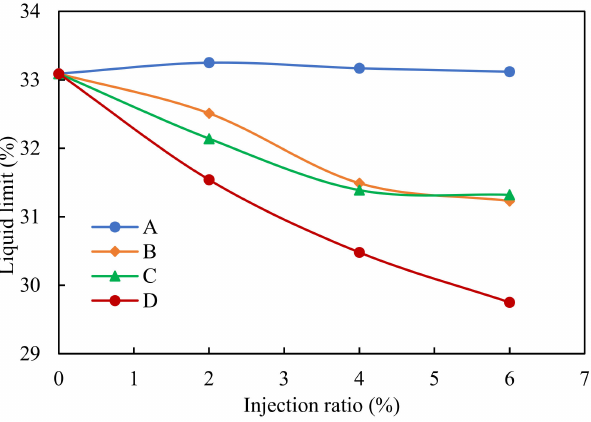
Figure 10. Variation in the liquid limit with the injection